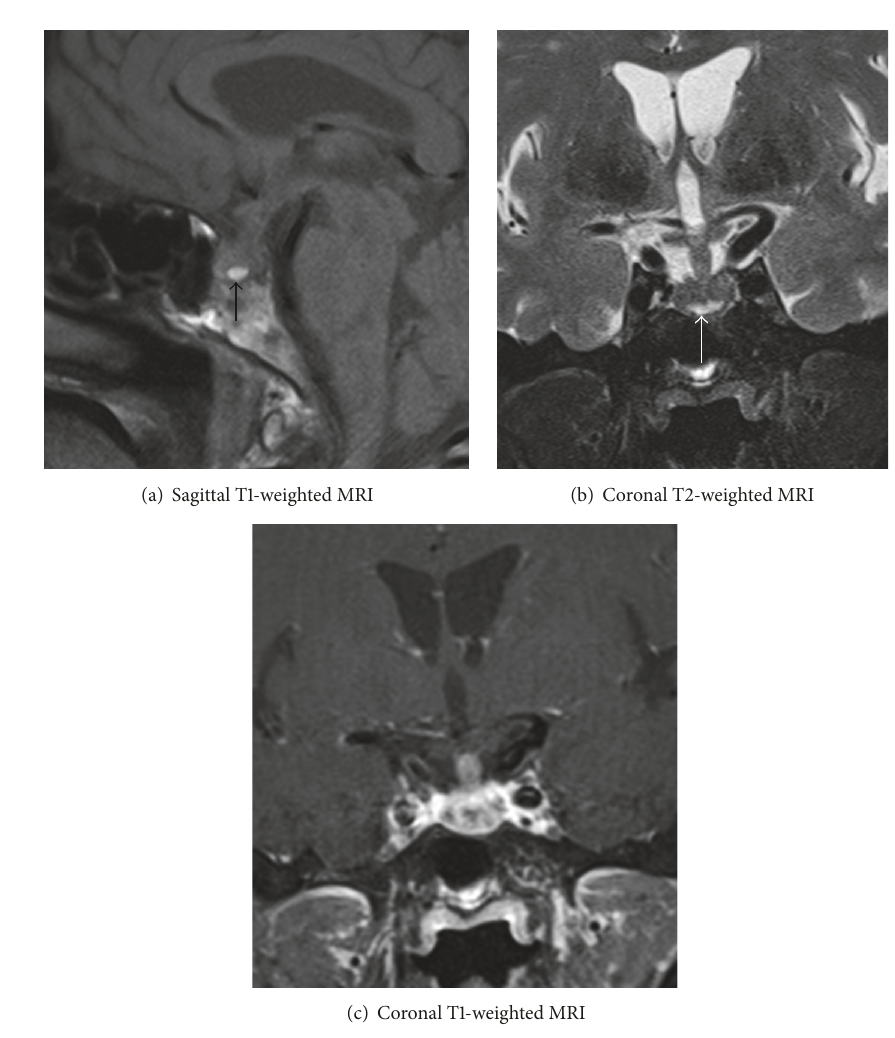
Figure 1: Inhomogeneity of the pituitary indicative of local metastases. Sagittal T1-weighted MRI (a) and coronal T2-weighted MRI (b) of the pituitary showed signal increase suggesting hemorrhage (arrows). Coronal T1-weighted MRI (c) with contrast shows inhomogeneous enhancement of pituitary with